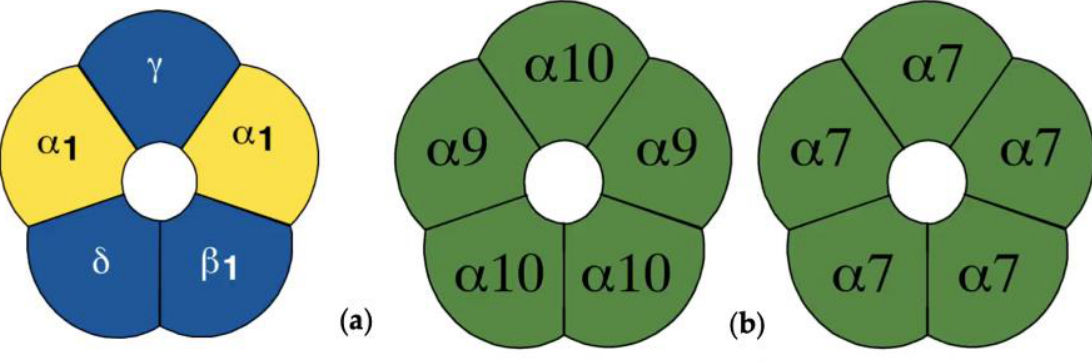
Figure A1. Alignment colorscheme: (a) CLUSTALX based on the threshold criteria and amino acid profile; (b) hydropathic character with the most hydrophobic residue being red, and blue being the most hydrophilic; (c) physicochemical character. Adapted from the documentation of Jalview [28].